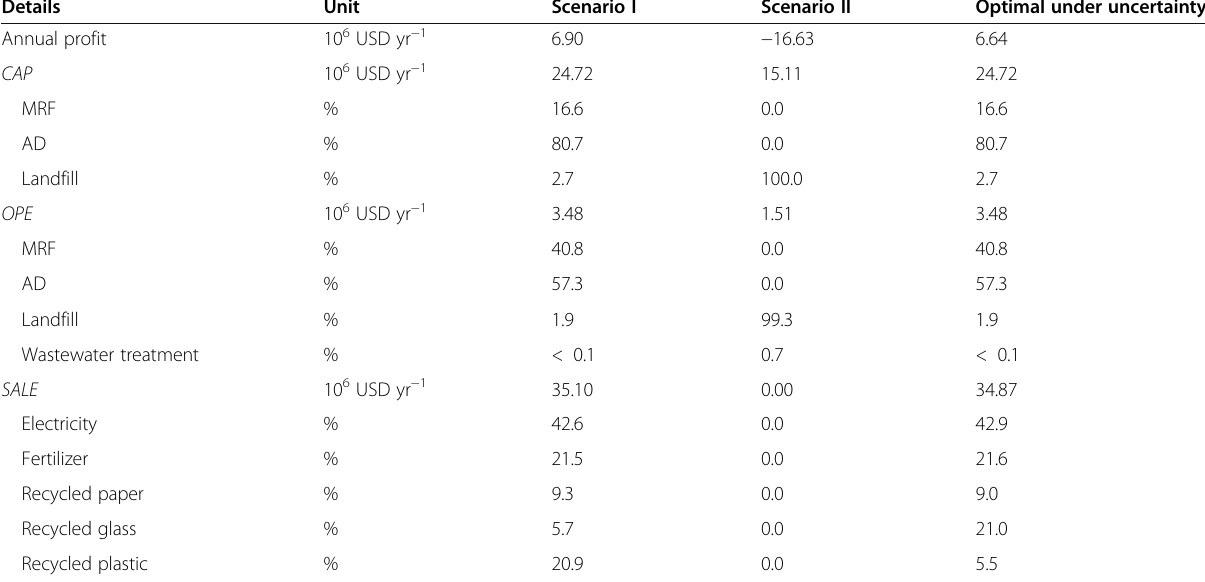
Table 4 Summary of the optimal waste processing facilities in Scenarios I, II and the optimal waste processing facility under uncertainty